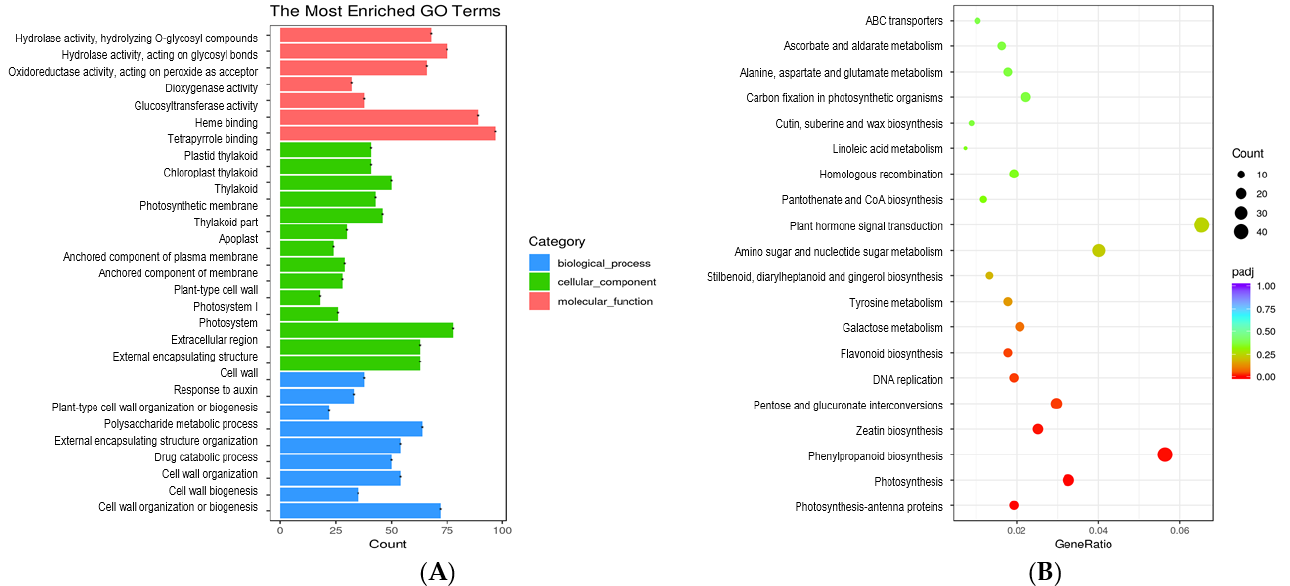
Figure 6. Gene ontology (GO) enrichment analysis ( A ) and scatter plot of KEGG pathways enriched ( B ) with differentially expressed genes (DEGs) detected in the comparison A3_2 vs. A2_2. For Figure 6B, the point size represented the number of DEGs, and colors indicated p adj ranges. p adj < 0.05 indicates significant enrichment. The abscissa is the ratio of the number of DEGs annotated with a Kyoto Encyclopedia of Genes and Genomes (KEGG) pathway to the total number of DEGs, and the ordinate is the KEGG pathway.